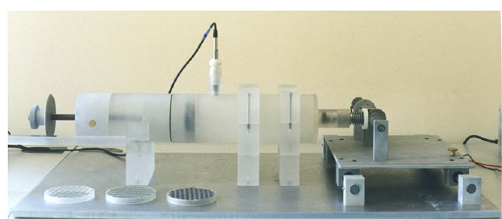
Figure 3. Experimental test-rig used for airflow resistivity